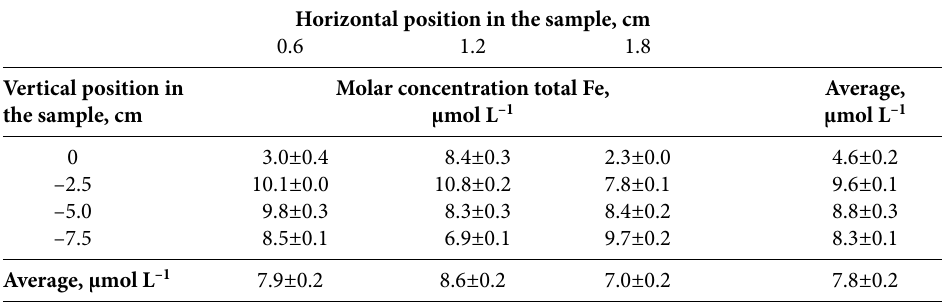
Table 2. Concentrations of total Fe in the Chelex-100 resin.